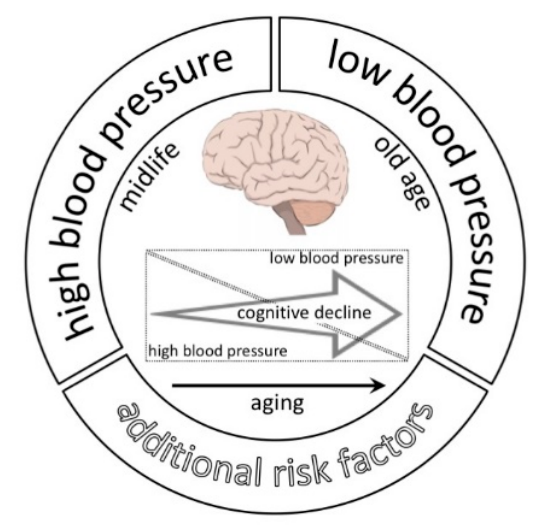
Figure 1. Relationship between BP and cognitive decline. The relative impact of high BP on cognitive dysfunction progressively declines with aging, while the influence of low BP progressively in- creases. The prolonged exposition to additional cardiovascular risk factors further contributes to the onset and progression of cognitive dysfunction.